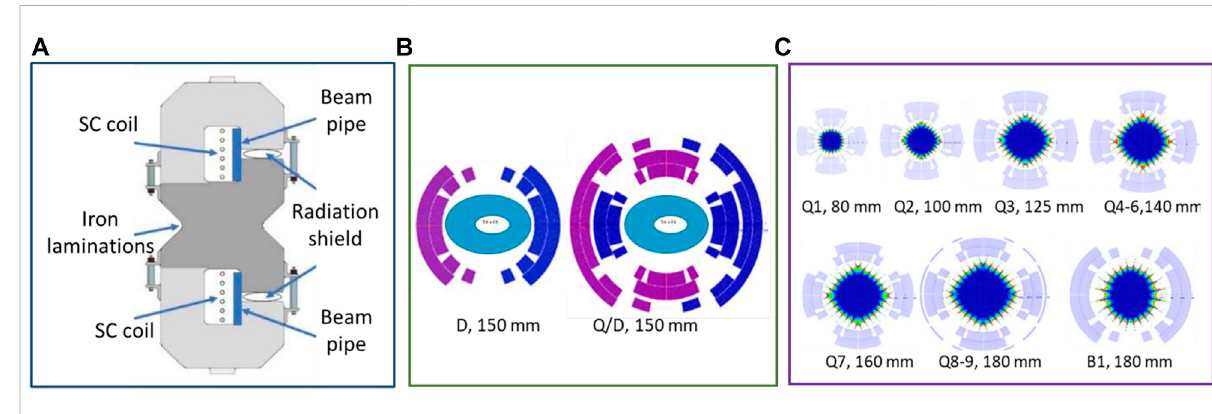
FIGURE 9 MC acceleration and SR magnets: (A) fast-cycling super-ferric dipole magnet with HTS coil, (B) collider dipole and combined function dipole- quadrupole magnets with thick elliptical absorbers in the apertures, (C) IR quadrupole and dipole magnets (good fi eld quality areas in the apertures are shown in blue